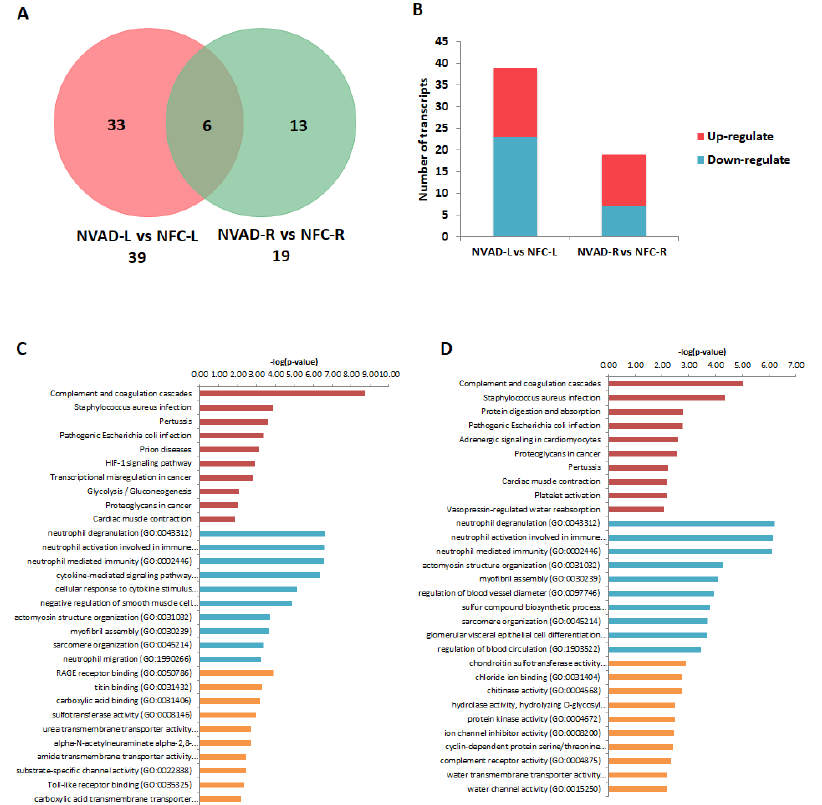
Figure 5. miRNA analysis of dilated cardiomyopathy (DCM) hearts without left ventricle assist device (NVAD) versus non-failing controls (NFC). ( A ) Number of significant differentially ex- pressed miRNAs in the left (L) and right (R) ventricles. ( B ) Number of significantly up- and down-